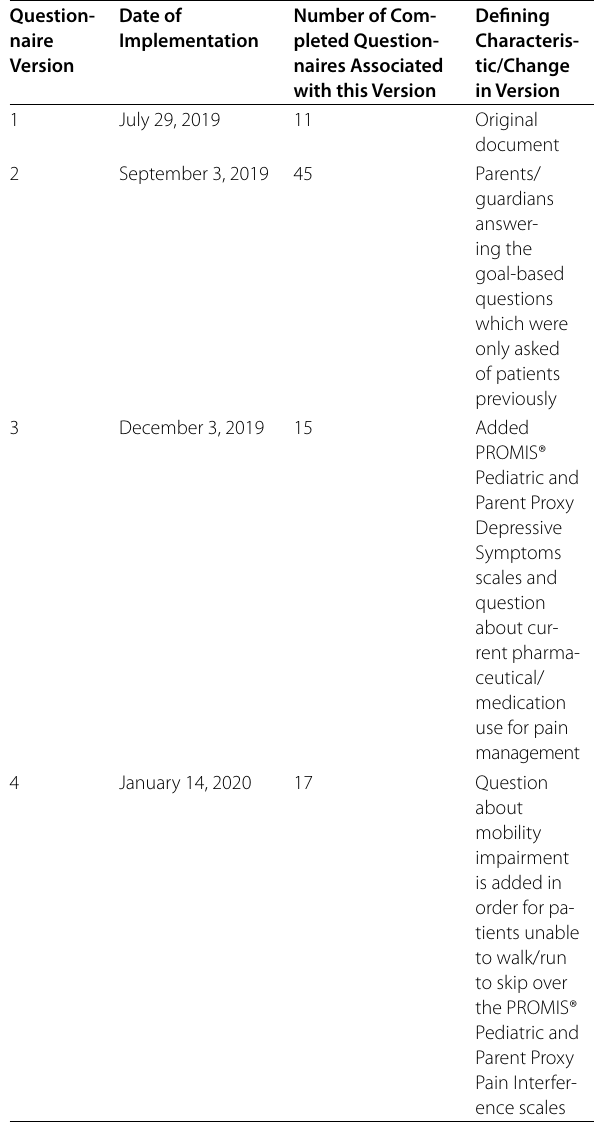
Table 1 Versions of the Questionnaire